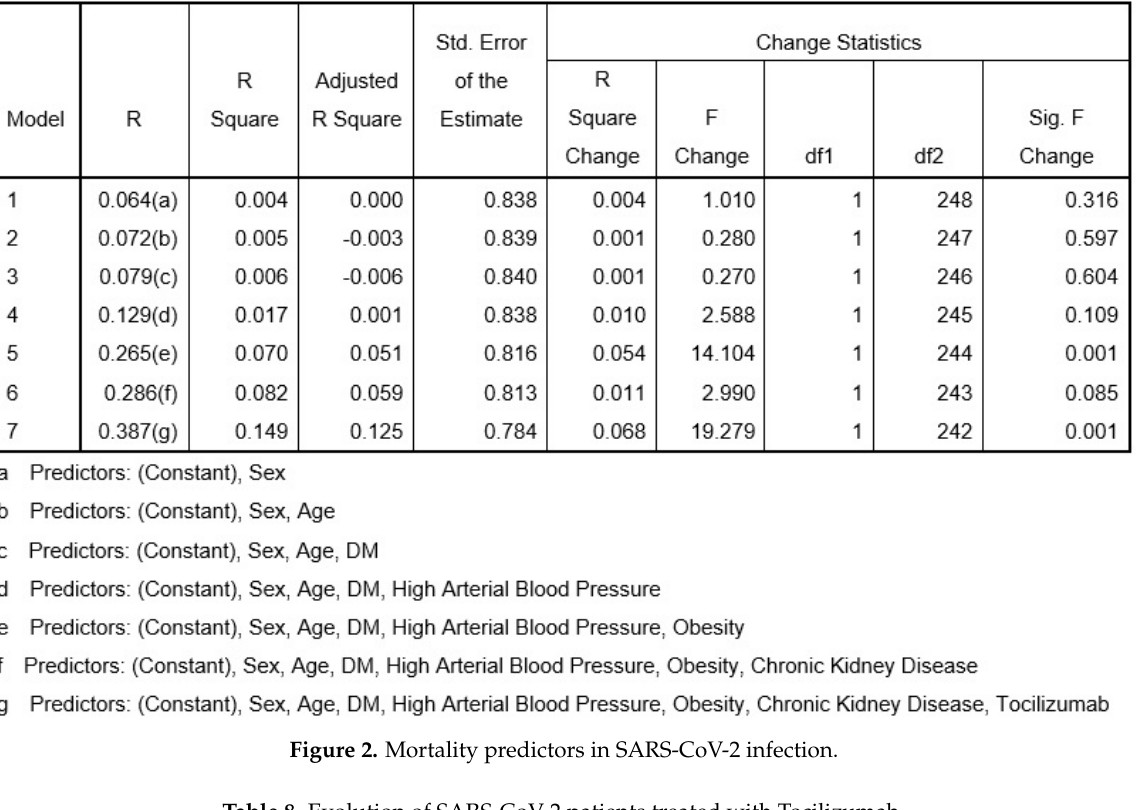
Figure 2. Mortality predictors in SARS-CoV-2 infection.